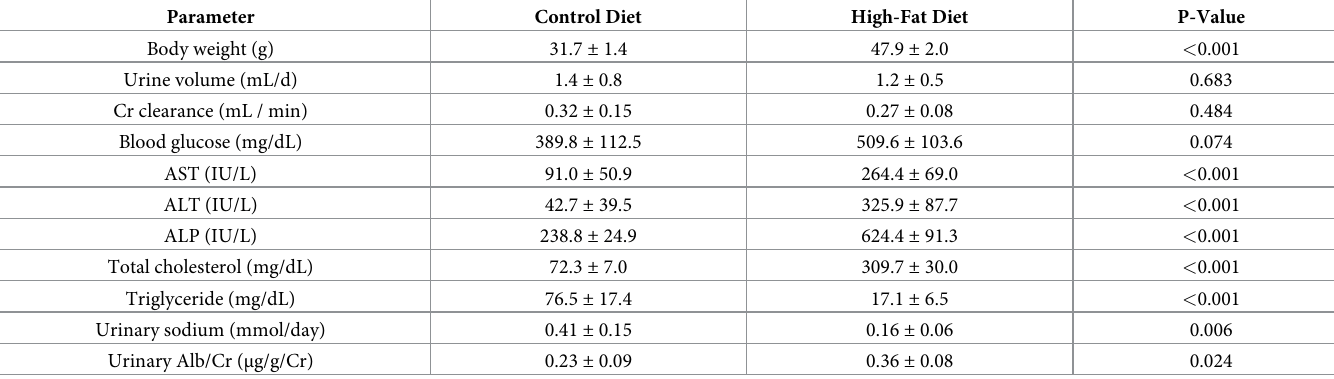
Table 2. Metabolic parameters of the two groups.